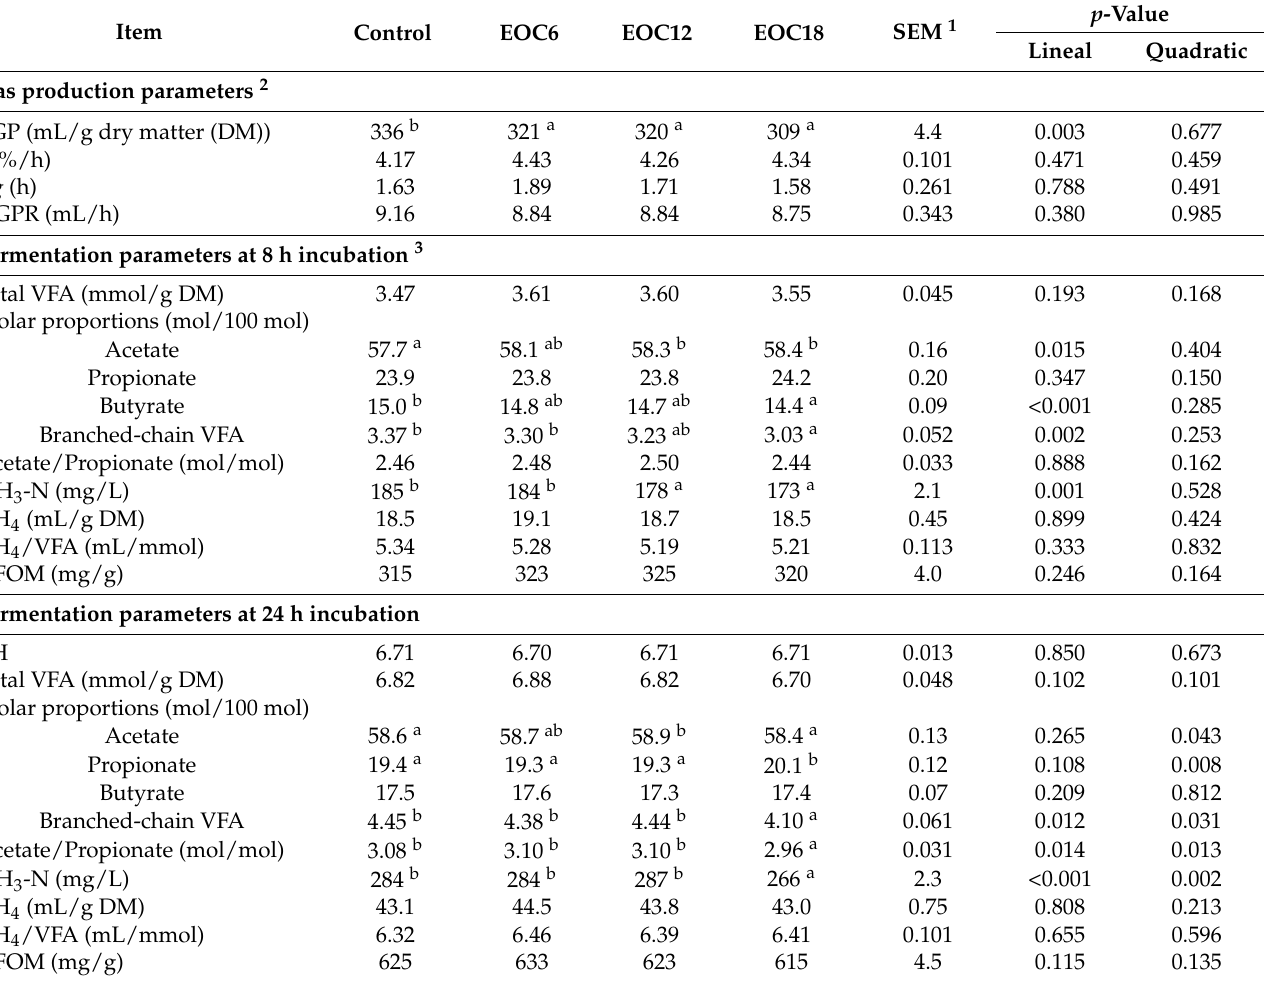
Table 4. Gas production parameters and fermentation parameters after 8 and 24 h of in vitro fermenta- tion of diets with increasing amounts (0 (Control), 6 (EOC6), 12 (EOC12), and 18 (EOC18); fresh